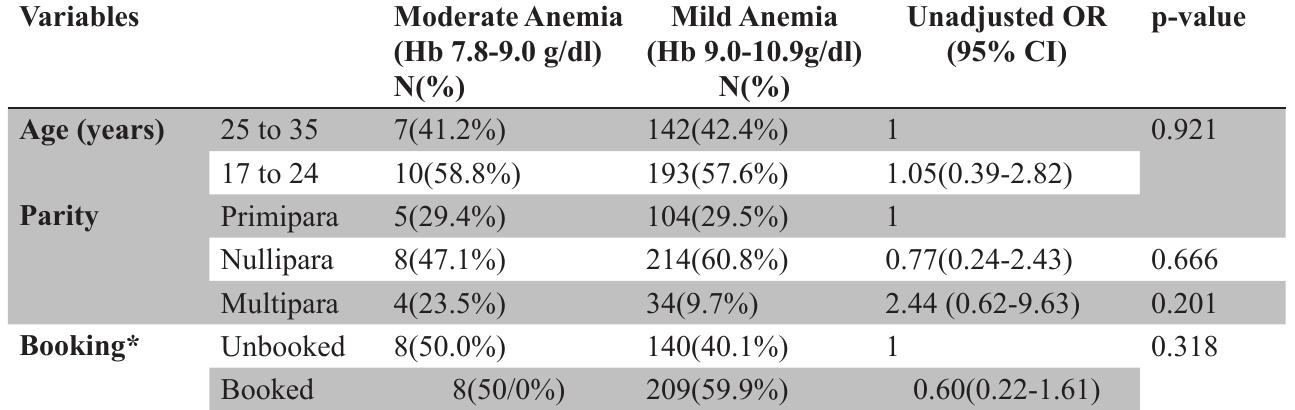
Table 3. Social and clinical characteristics associated with anemia in pregnancy